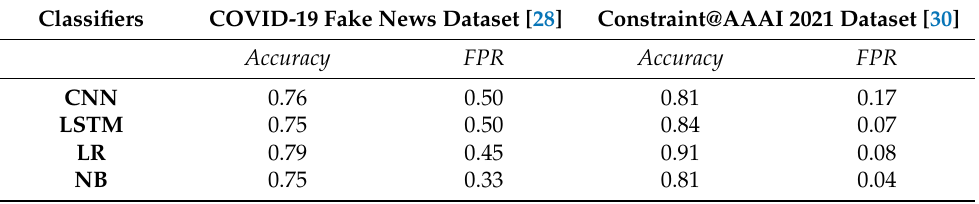
Table 7. Comparison of DL and ML